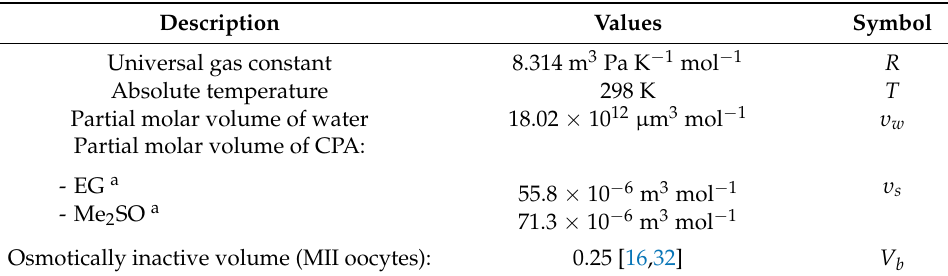
Table 1. Constant and parameters used in 2P